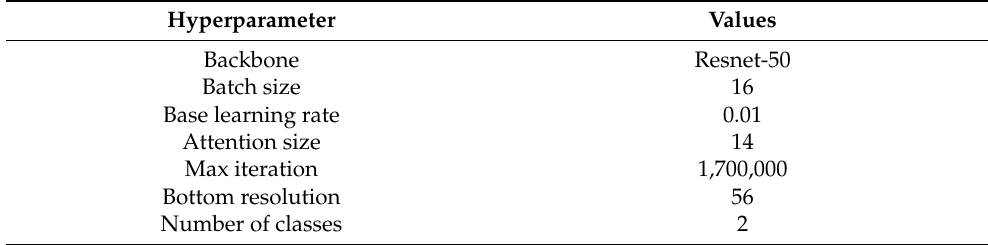
Table 2. Modeling hyperparameter settings.